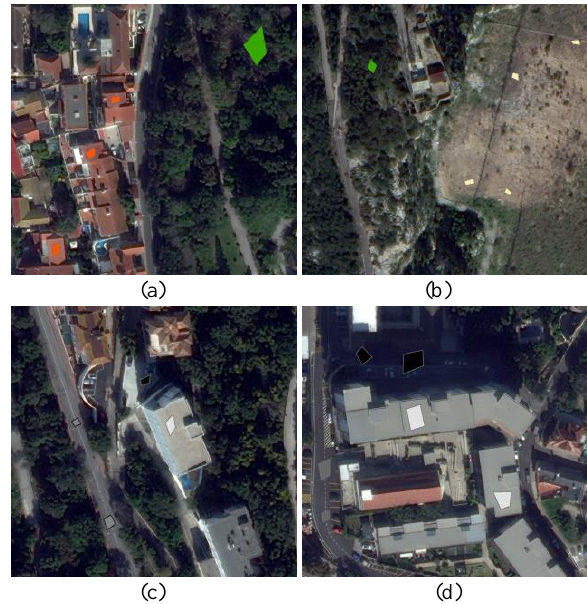
Figure 4. Sample training polygons defined on MAXAR image of Gibraltar test site. (a) Building_1 and vegetation, (b) vegetation and barren, (c) building_2 and (d) building_2 and shadow.